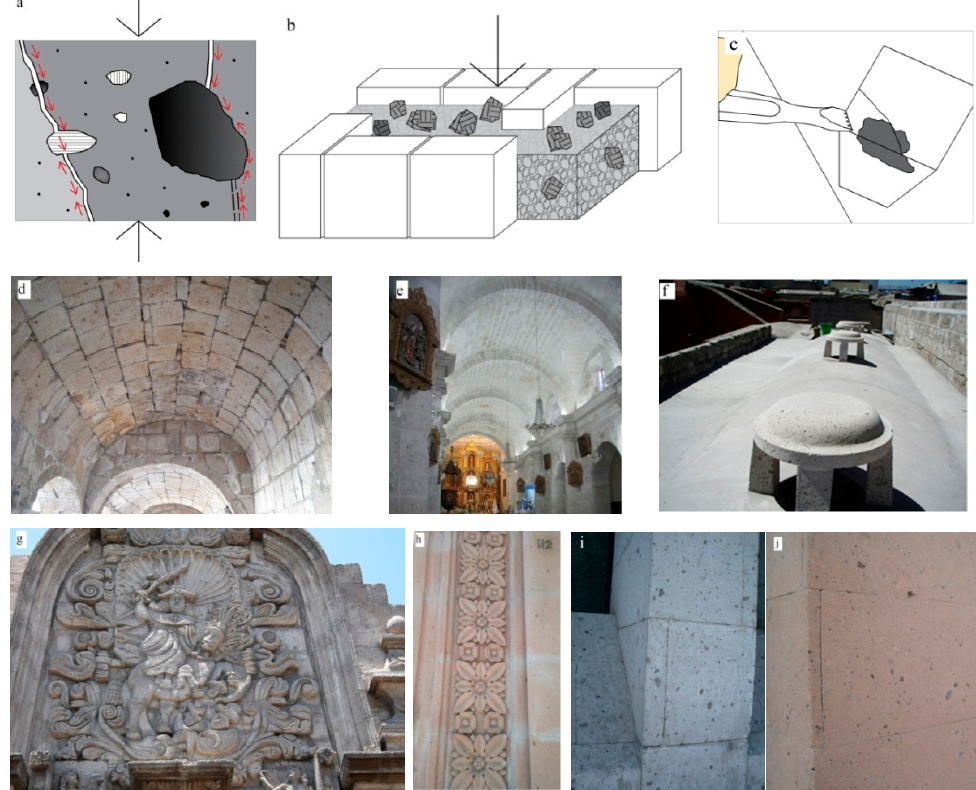
Figure 11. ( a ) Intergranular and through vacuole breakage; ( b ) mixed masonry; ( c ) carved with sharp claw chisel; ( d ) barrel vault; ( e ) intrados with transverse ribs; ( f ) ignimbrite skylight on the vault; ( g ) colonial carving of the James the Apostle (La Compañía de Jesús); ( h ) carved quadrifolia from the first half of the 20th century; ( i , j ) Wt and Pk ignimbrite cladding.